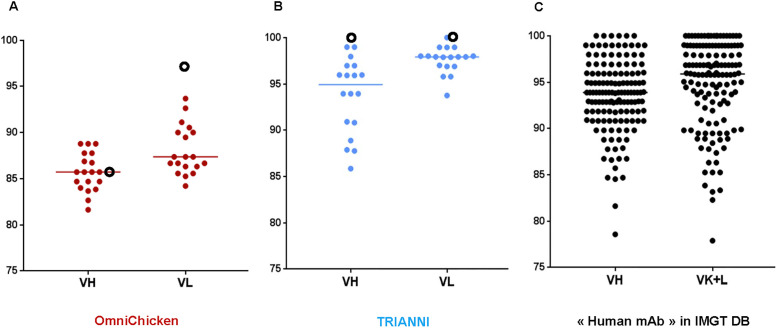
IGV protein identity to human germline of OmniChicken- and TRIANNI-derived anti-LAMP1 mAbs compared to the IGV protein identity of a panel of 140 human antibodies tested for therapeutic applications in humans.Shown are the identities for the heavy and light chain V gene sequences of 19 OmniChicken-derived mAbs (brown), 18 TRIANNI-derived mAbs (blue) and 140 human antibodies tested in the clinic (green). Black empty circles represent the SynVH-C and SynVκ-C sequences inserted in the OmniChicken platform and the 44 VH and 39 VL sequences inserted in the TRIANNI platform.